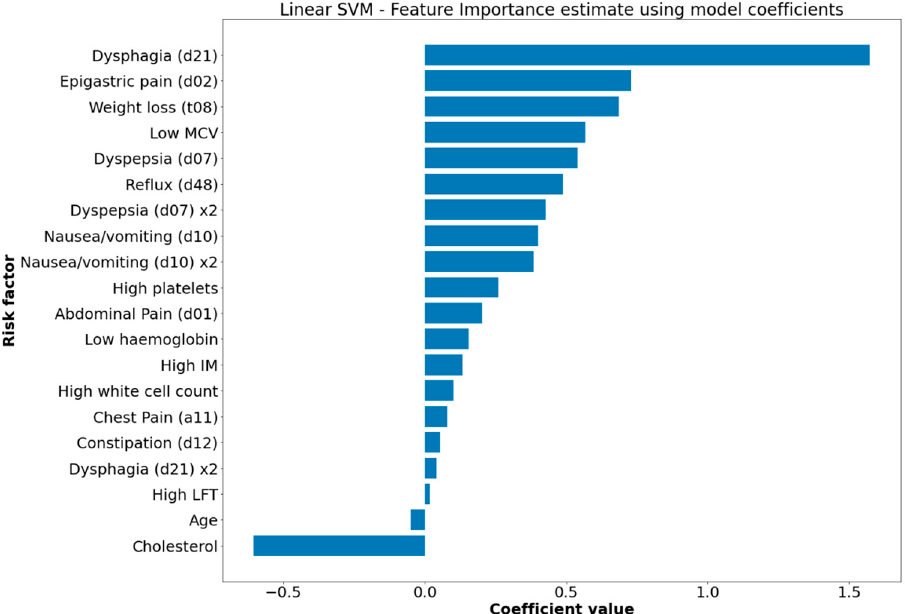
Figure 1. Feature importance graph displaying relative contribution of diagnostic factors for oesophago-gastric cancer to model risk score. Model: Support Vector Machine (with linear kernel). Feature weights represented by model coefficients. Generated with matplotlib [41].